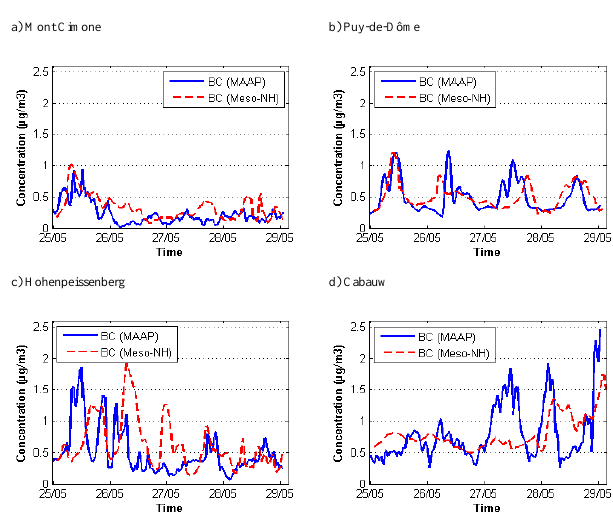
Figure 6. Evolution of the BC mass concentration (µgm − 3 ) simu- lated (red dashed line) and measured (blue solid line) between 25 and 29 May